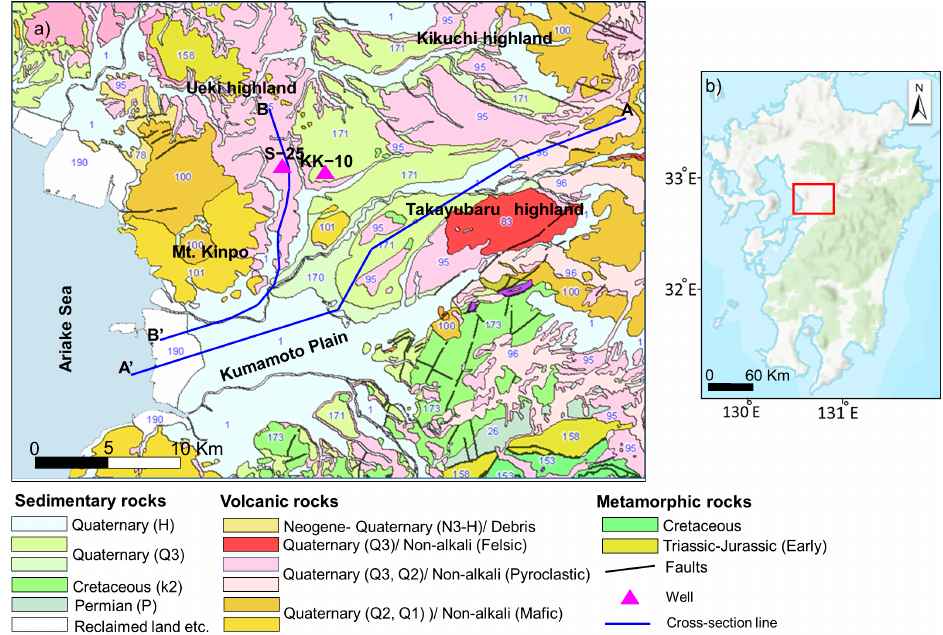
Figure 1. ( a ) Geological map of the study area [55]. ( b ) Location map of the study area (red rectangle) created using ArcGIS ® software by Esri. The red rectangle indicates the location of panel